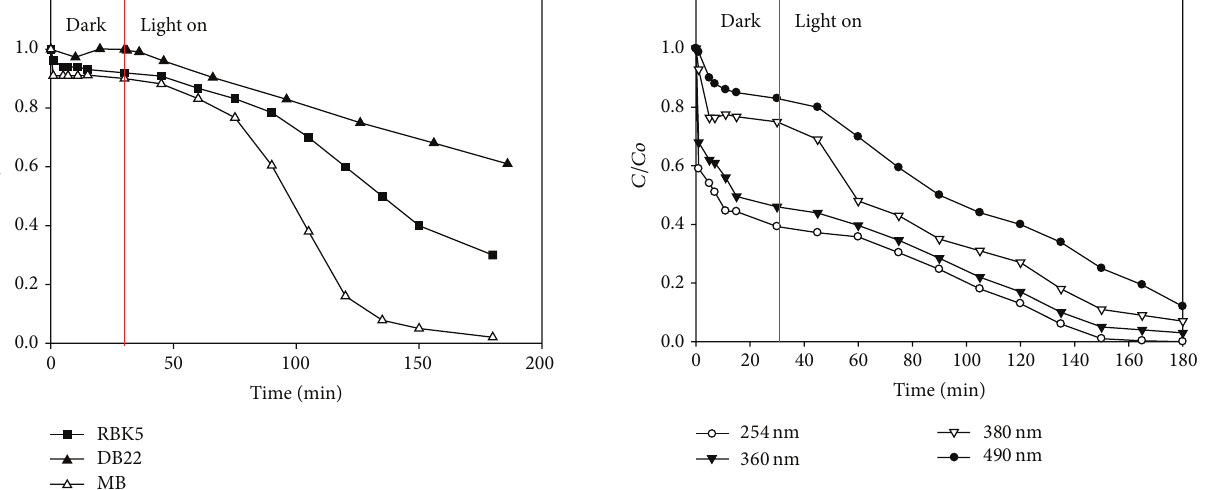
Figure 9: The effect of light source on degradation efficiency for 10ppm MB removal and catalysts loading of 0.04gL −1 with 1.13% Fe TNT.